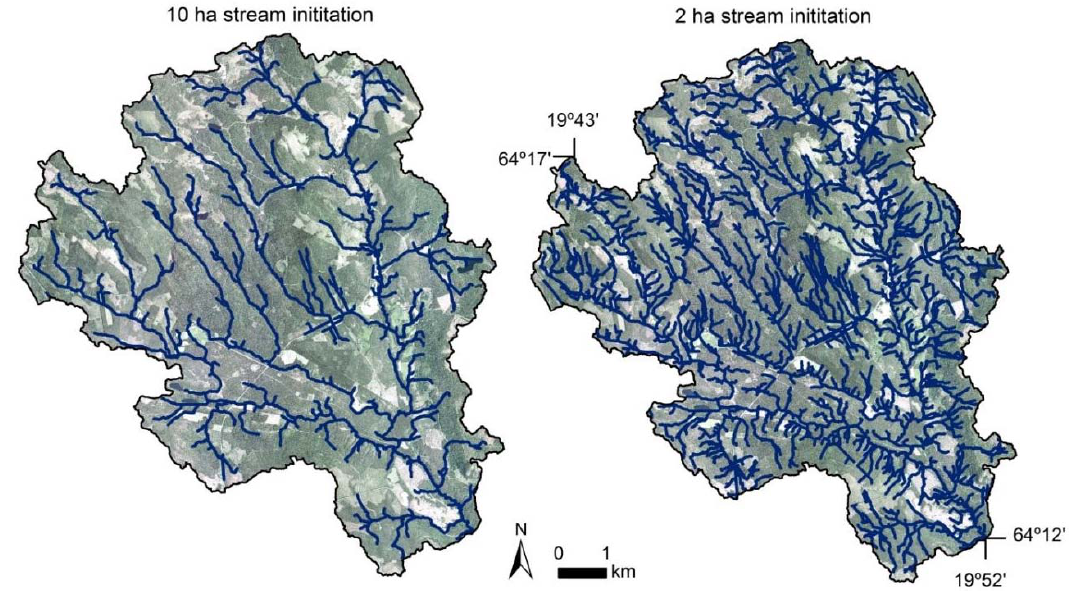
Figure 3. The stream network in the Krycklan Catchment during baseflow ( left ) (using 10 ha stream initiation threshold) and spring flood ( right ) (using 2 ha stream initiation